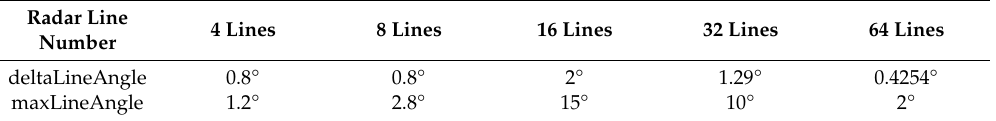
Table 4. 3D LiDAR